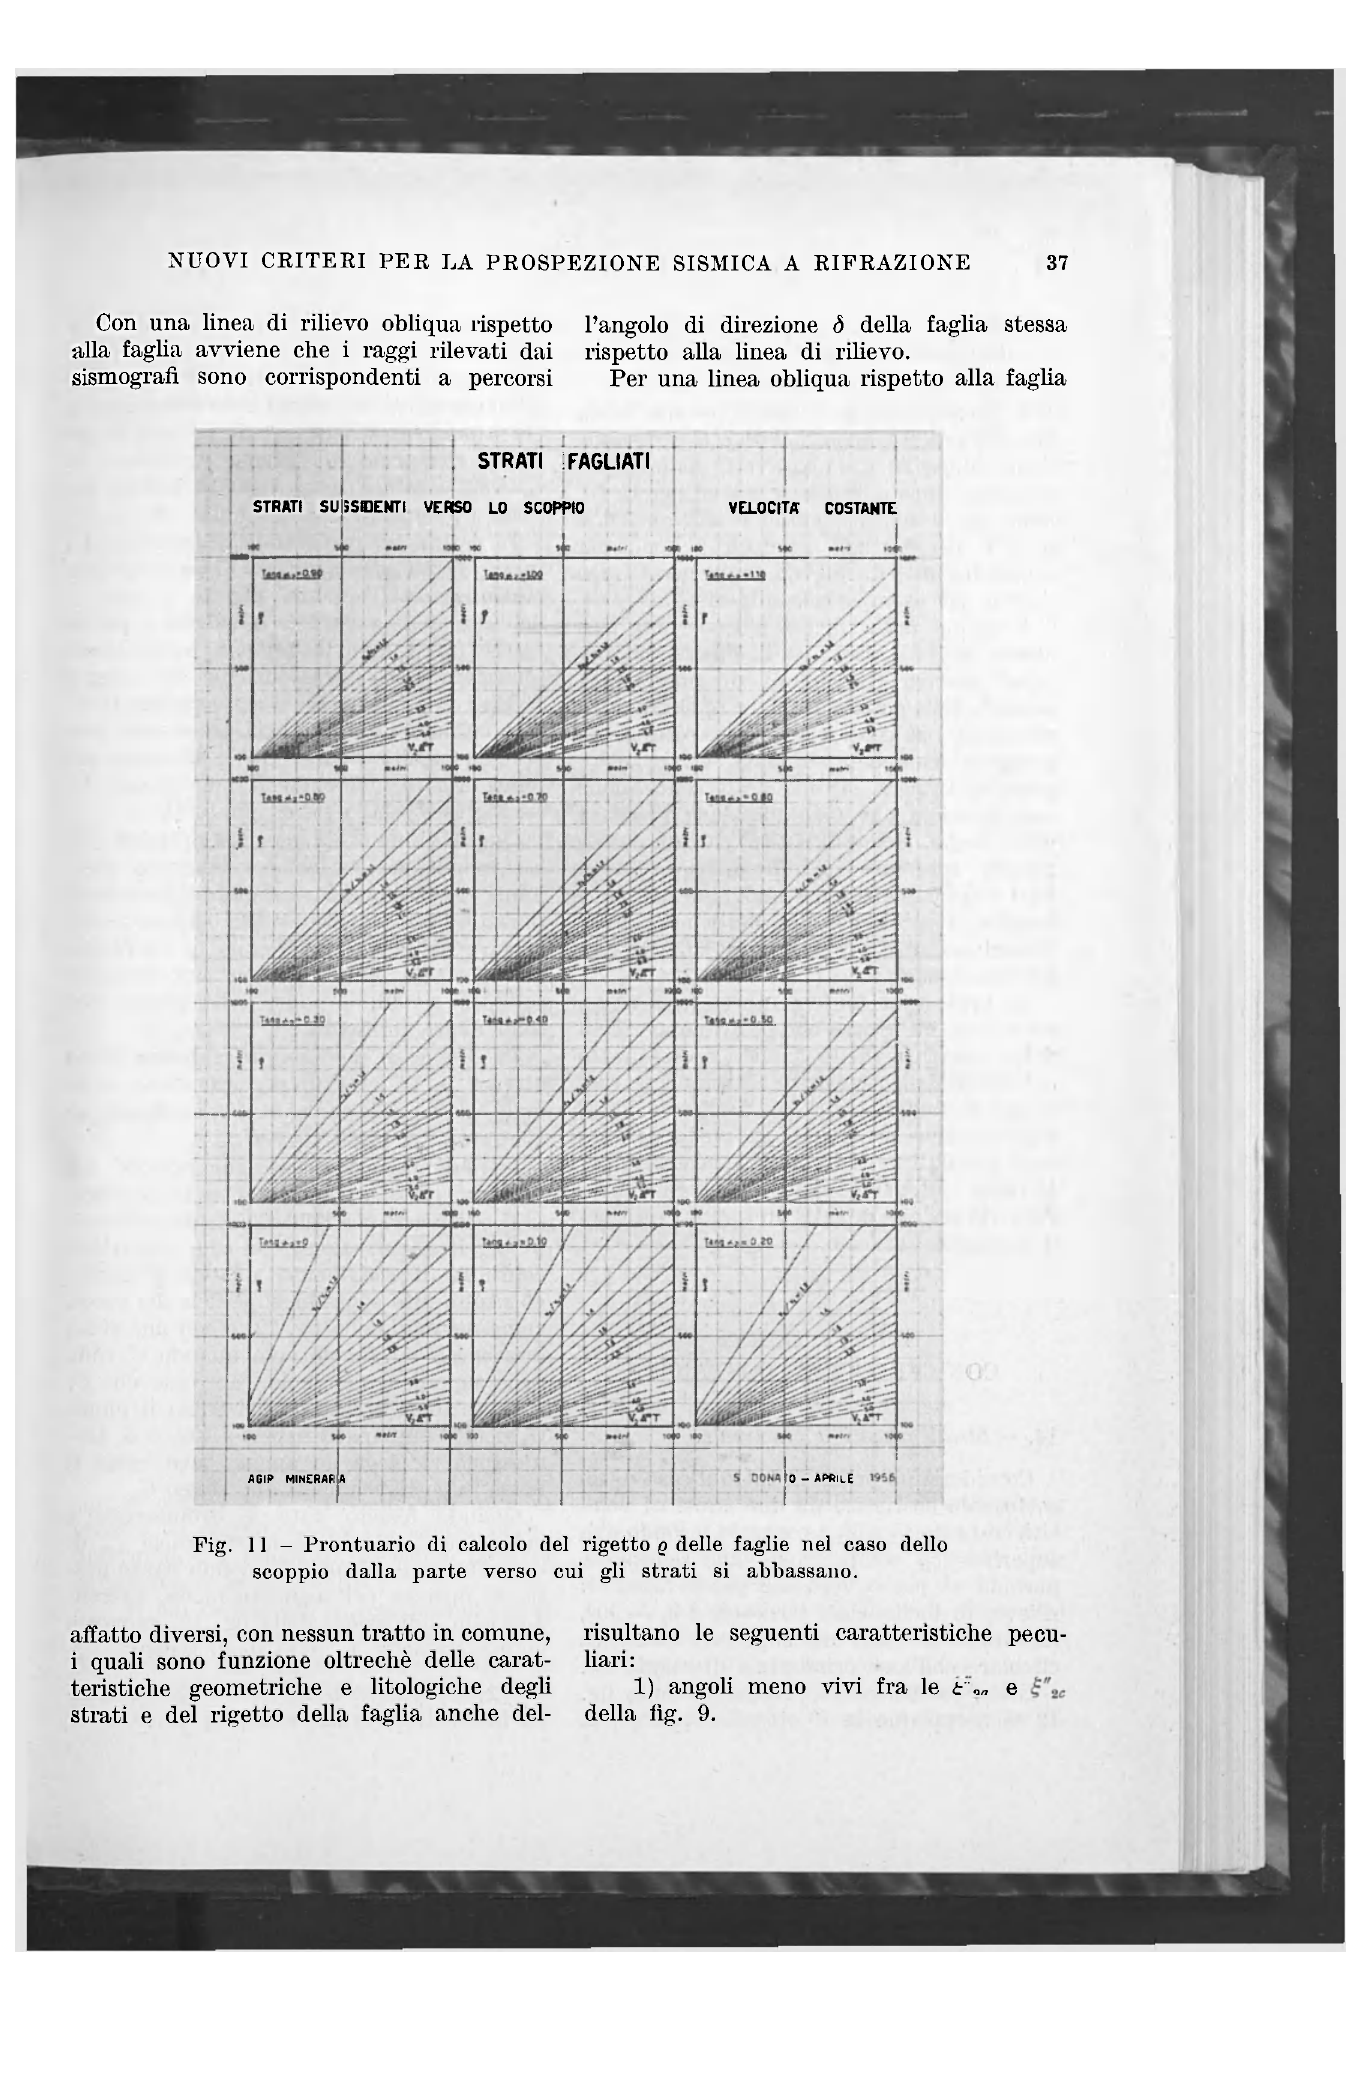
Fig. 11 - Prontuario di caicolo del rigetto Q delle faglie nel caso dello scoppio dalla parte verso cui gli strati si